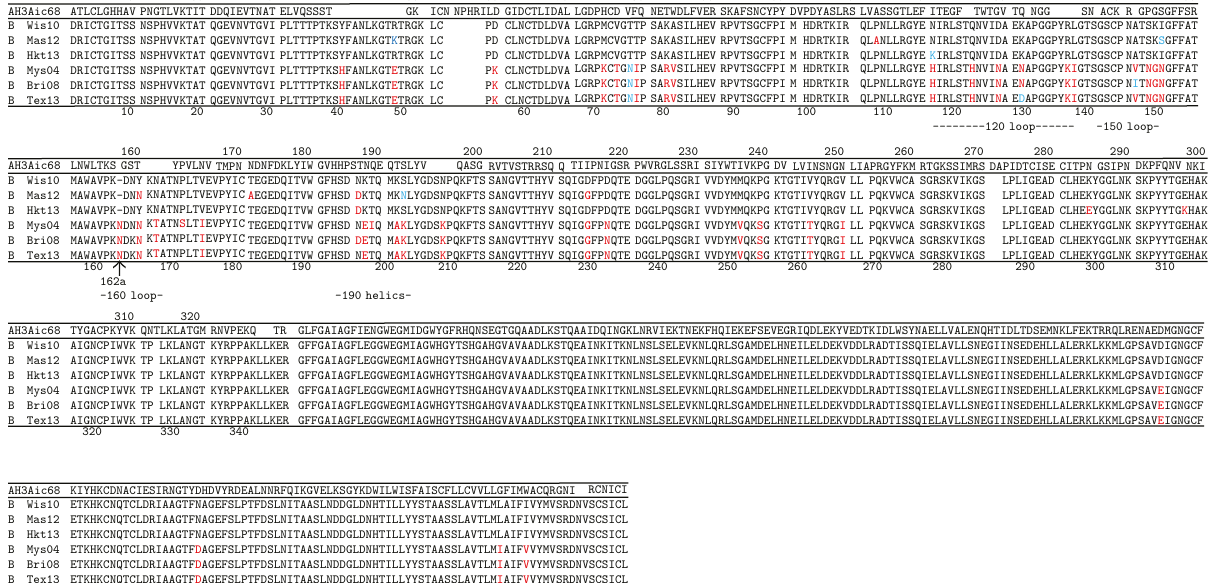
Figure 11: Comparison of amino acid sequences of HAs among three Yamagata lineage strains and three Victoria lineage strains of in fl uenza B viruses. The HA sequence of A/Aichi/2/68 (H3N2 strains of in fl uenza A virus) indicated on the top as a standard